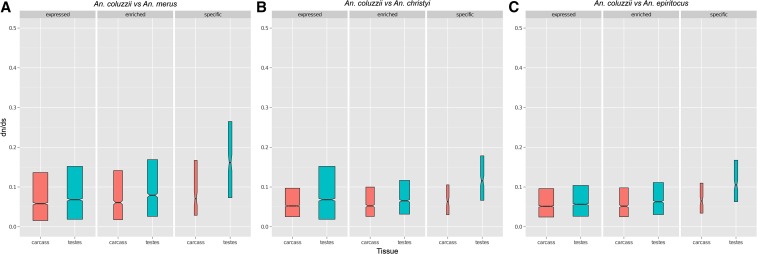
Testes-biased genes show accelerated evolution relative to carcass-biased genes (A–C). Notched box-plots display the median, 25th, and 75th percentile values of dN/dS ratios (untransformed) between A. coluzzii and three comparator Anopheles species: A. merus (A), A. christyi (B), and A. epiroticus (C). dN/dS were assessed among tissue types (carcass and testes) based on expression profile (expressed, enriched, or specific). The width of each box-plot is proportional to the square root of the sample size. Regardless of the species used for comparison, testes-biased genes show elevated dN/dS values relative to genes with other expression profiles.